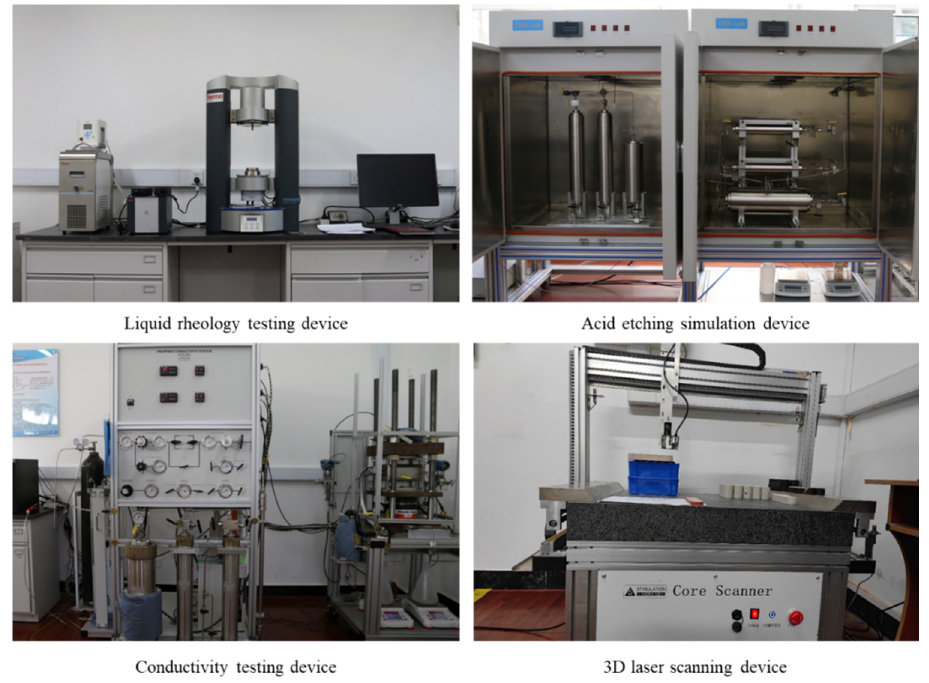
Figure 2. Acid fracturing conductivity test